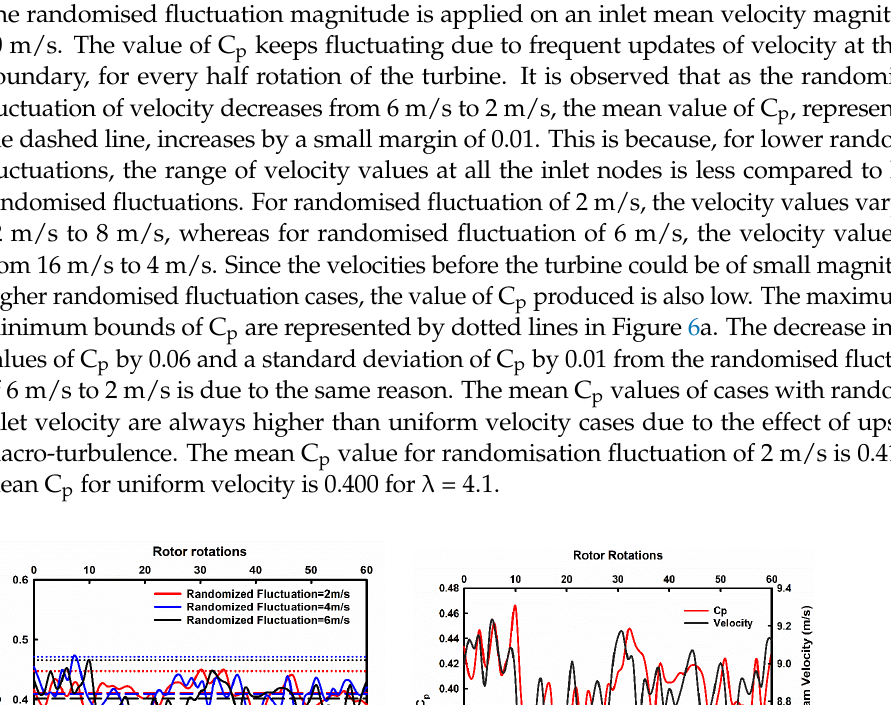
Figure 6. ( a ) Variation of Cp for various randomised fluctuation; the mean and minimum maximum is represented in the graph with the help of dashed lines and dotted lines respectively; ( b ) Effect of free stream velocity on Cp.